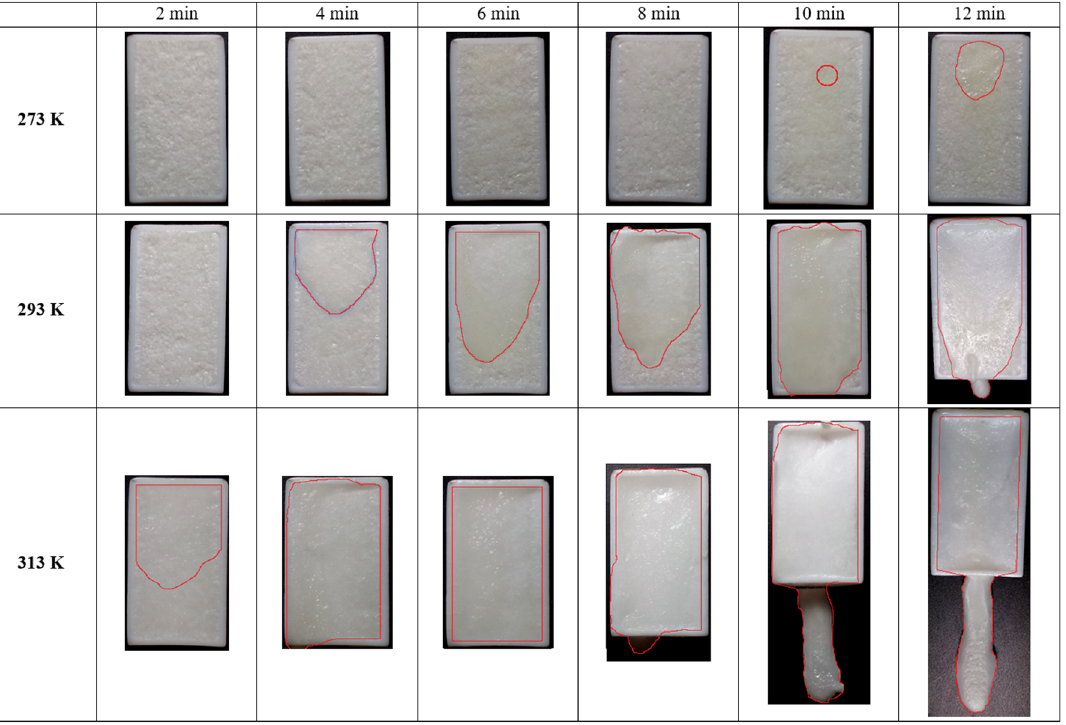
Figure 5. Sample images during experiment at different onset temperatures. Sample positioning on picture is up = front position, down = back position, relative to gas